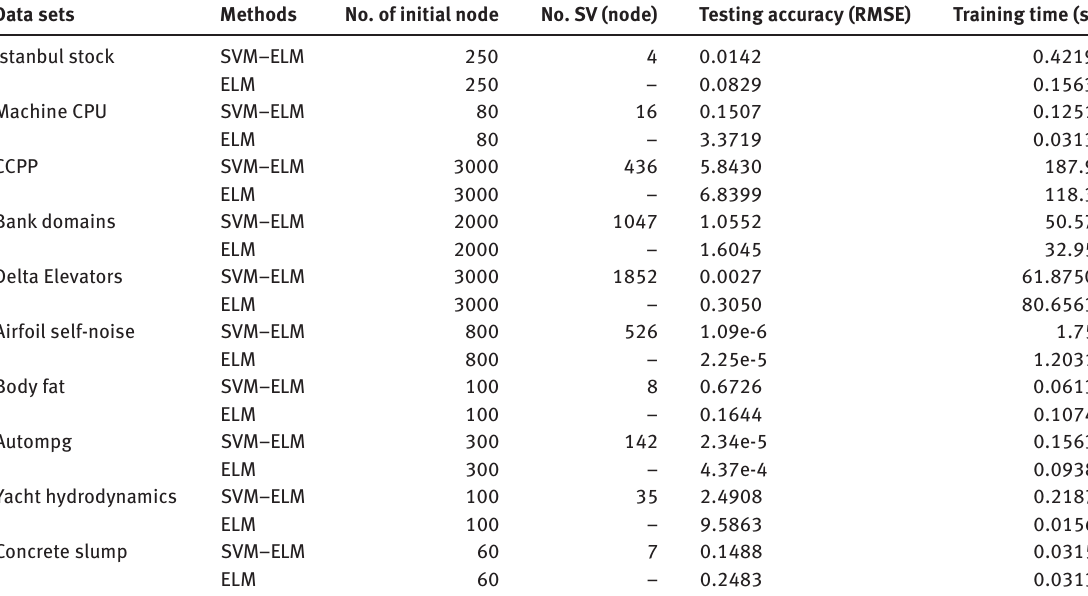
and SVM–ELM sig sig